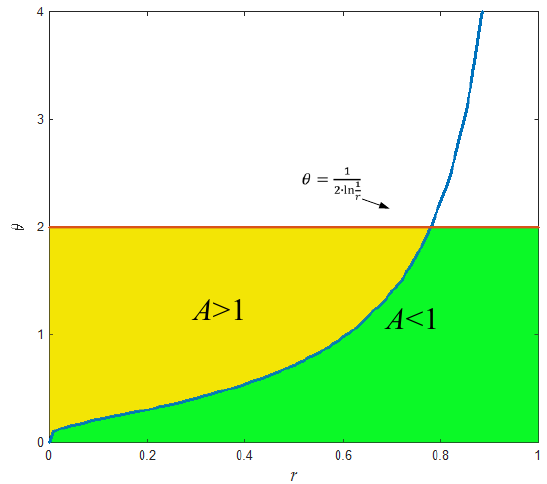
Figure 6. Schematic diagram of probability calculation of detour food searching.